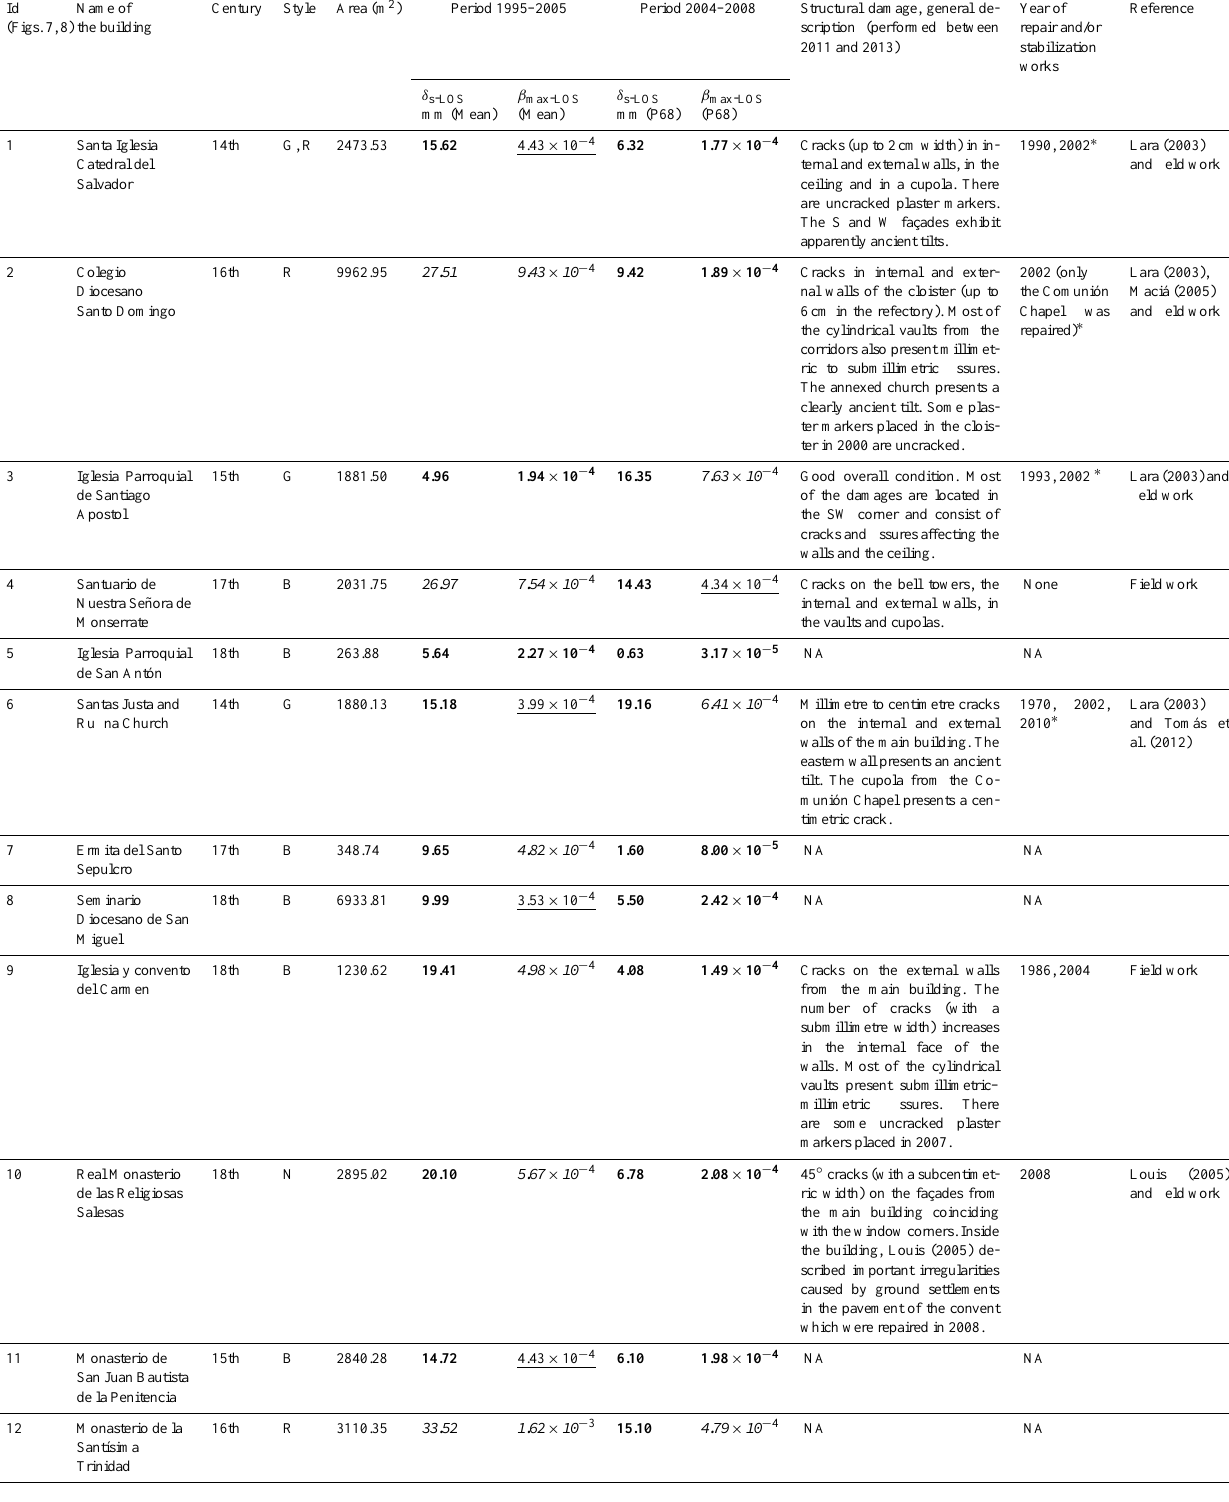
Table 5. Note that angular distortions ( β max - LOS ) and ( δ smax - LOS ) values provided by InSAR for both periods have been classified using the font format set in Table 1 (bold for negligible, underlined for medium and italic for high). NA: not available; R: Renaissance; G: Gothic; B: Baroque; N: neoclassical; U: unknown. ( ∗ ) Total or partial underpinned